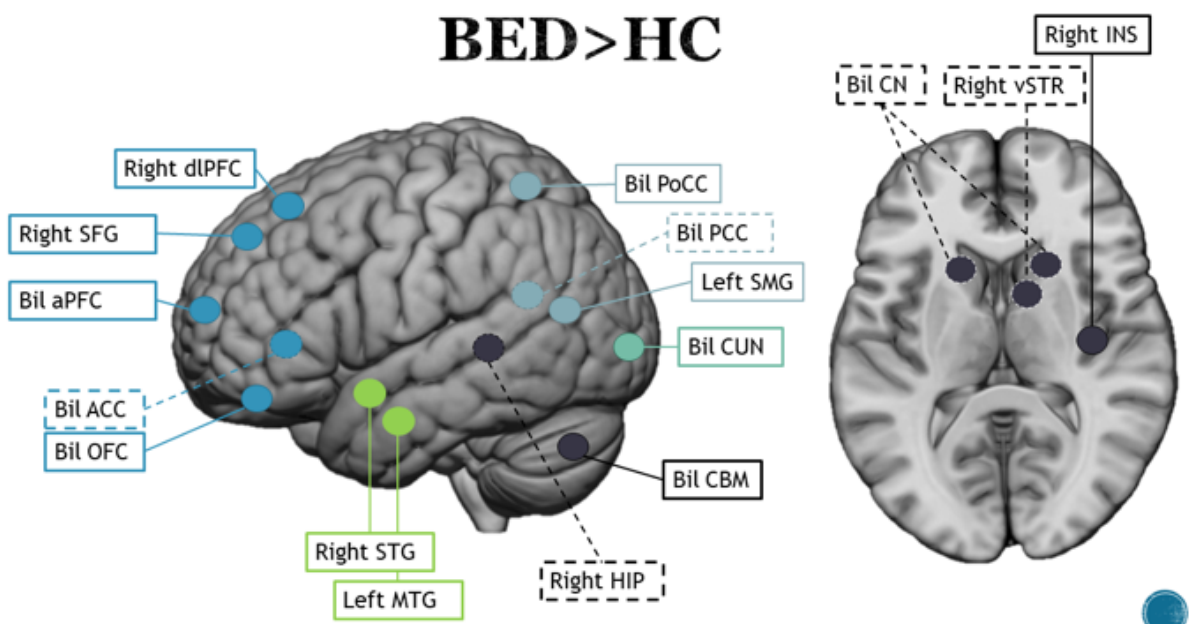
Figure 4. Main brain areas observed in the contrast between binge eating disorder patients and healthy controls. Blue lines represent frontal areas, light blue represent parietal areas, green–blue lines represent occipital areas, green lines represent temporal regions and black lines represent subcortical regions and cerebellum. Dotted lines represent mesial regions, whereas solid lines represent lateral and superficial areas.